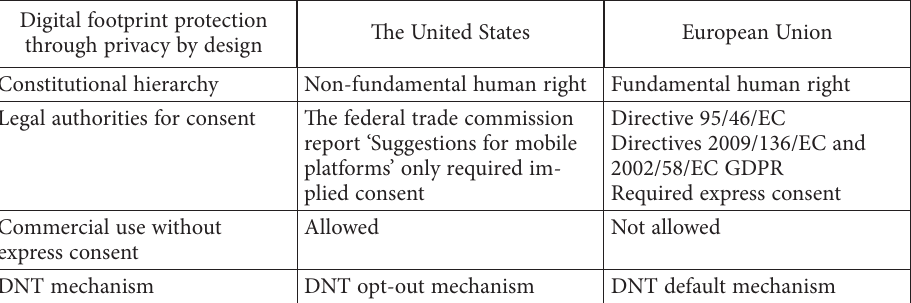
Table 1. Different policy attitudes to digital footprint protection through the privacy by design principle between the United States and European Union (source: compiled by authors) Digital footprint protection through privacy by